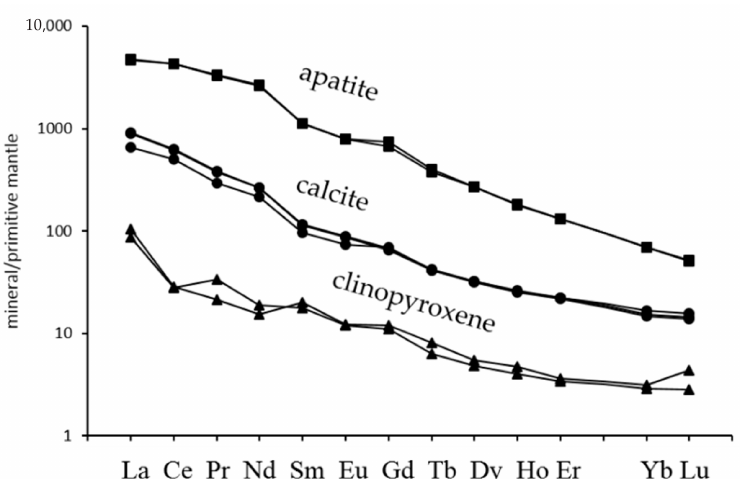
Figure 4. REE abundance diagram normalized to the primitive mantle of McDonough and Sun 1995 [78], showing patterns of apatite, calcite, and clinopyroxene on Fuerteventura